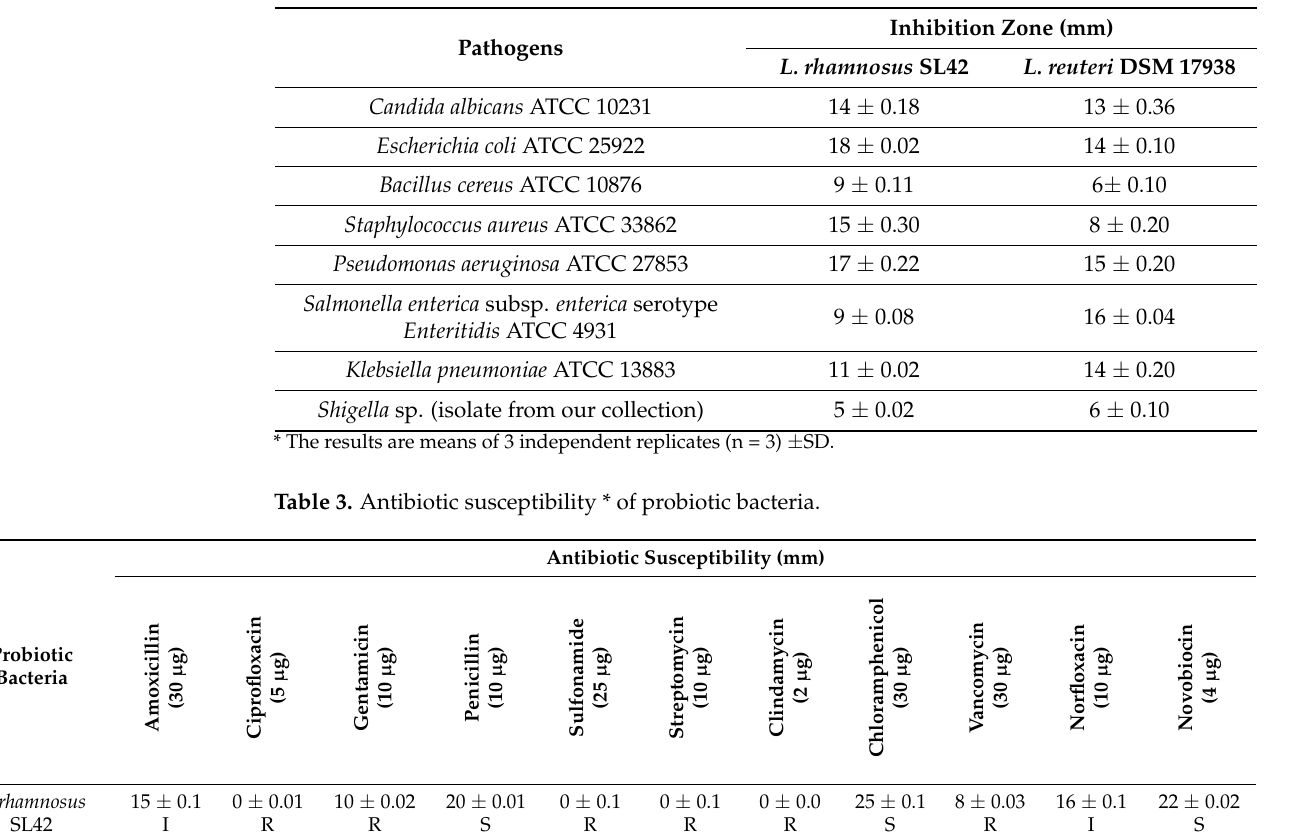
Table 2. Antimicrobial activity * of probiotic bacteria.